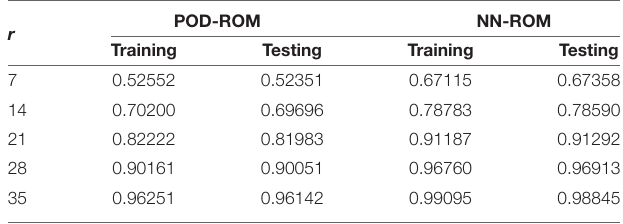
TABLE 2 | Relative kinetic energies preserved by the reconstructions of the POD-ROM and the NN-ROM solutions of the Lorenz’96 system on both the training and testing